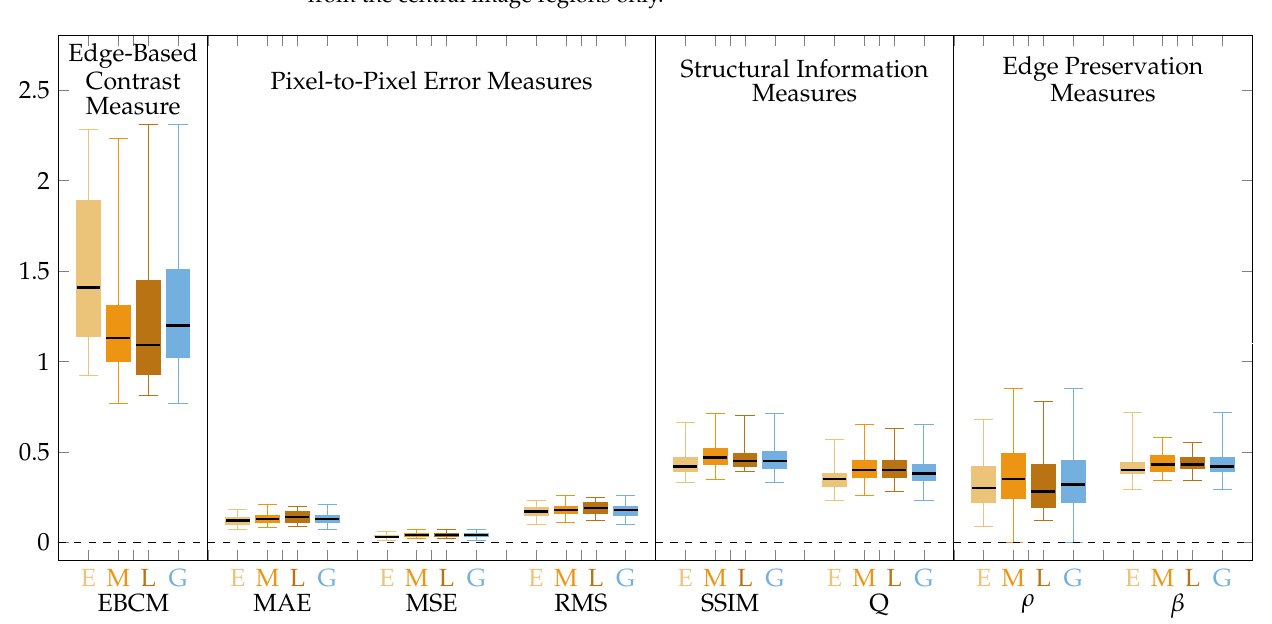
Figure 5. Quality measures for images processed by the proposed method. Measure values calculated for the peripheral image regions only.